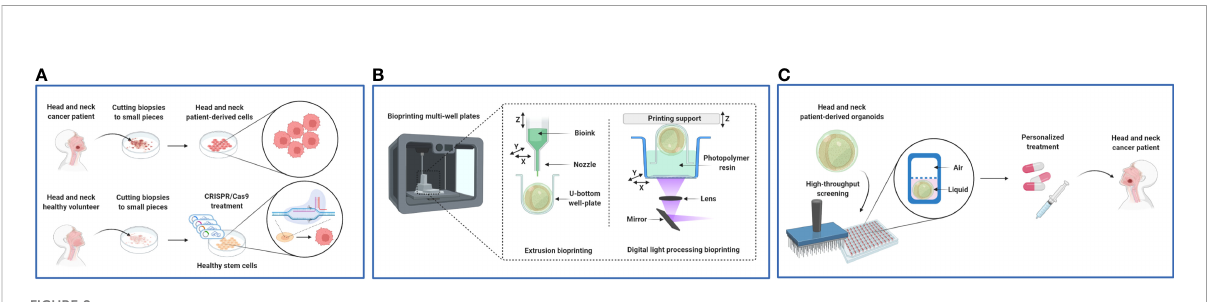
FIGURE 8 Future outlook of in vitro H&N cancer patient-derived organoid (PDO) models. (A) Sourcing of H&N PDO models using the tumor biopsies of cancer patients and CRISPR DNA – modi fi ed healthy cells. (B) Fabrication of H&N PDO models using bioprinting. (C) H&N PDO model life span used as air – liquid interface in HTS for personalized medicine purposes. Figure created with